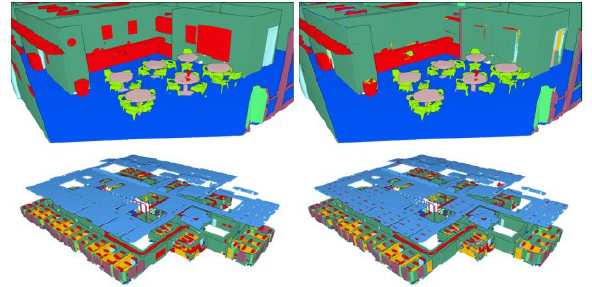
Figure 7 Ground-truth vs prediction for Area 5 of the PCID5